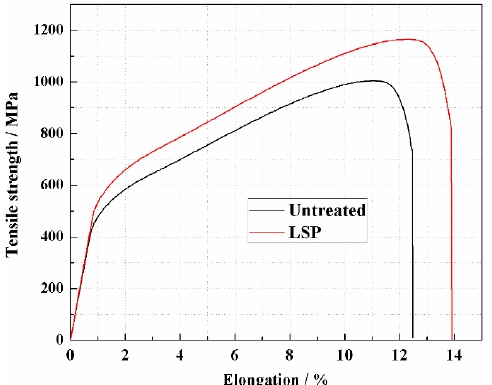
Figure 10. Engineering stress-strain curves of 40CrMo steel samples without and with LSP.